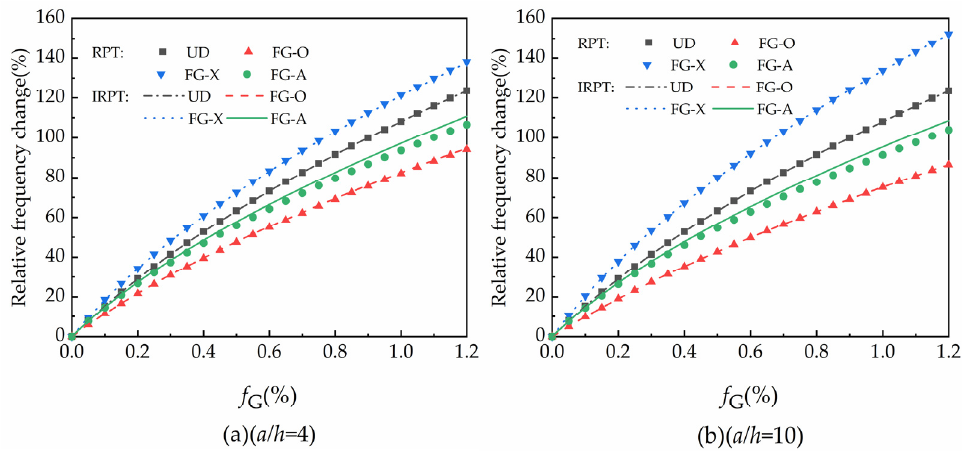
Figure 6. Relative frequency change in FG-GRC plates for / 4 a h = and / 10 a h = ( = 10